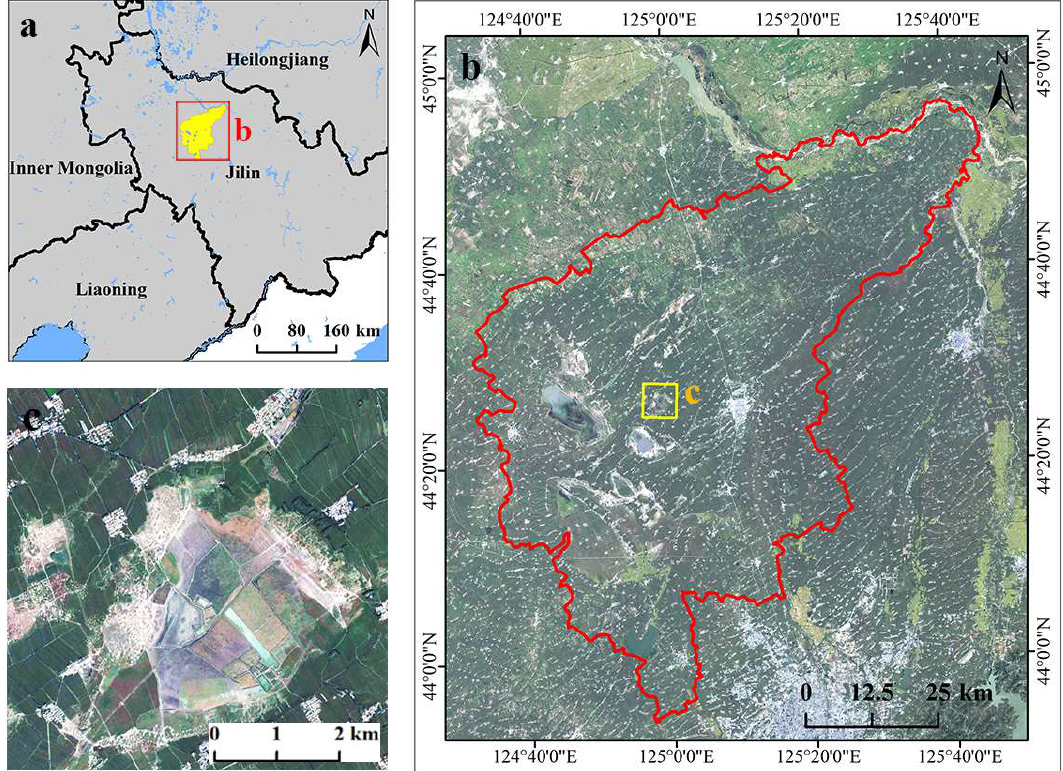
Figure 1. ( a ) Location of the study area in Jilin Province; the yellow area represents Nong’an County; ( b ) true–color composite image of the study area based on Landsat OLI; the red line represents the boundary of Nong’an County; ( c ) the Yuanbao pool where a high-density locust outbreak occurred.